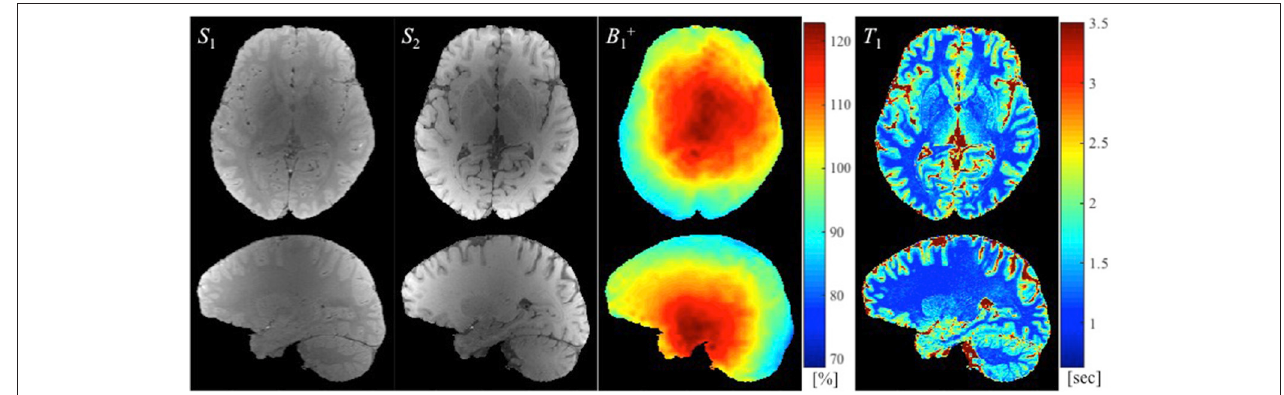
FIGURE 2 | The SPGR images with two different flip angles ( S 1 and S 2 in arbitrary units), the B + 1 map (in the percentage of nominal flip angle), and the estimated T 1 map (in seconds) are shown from left to